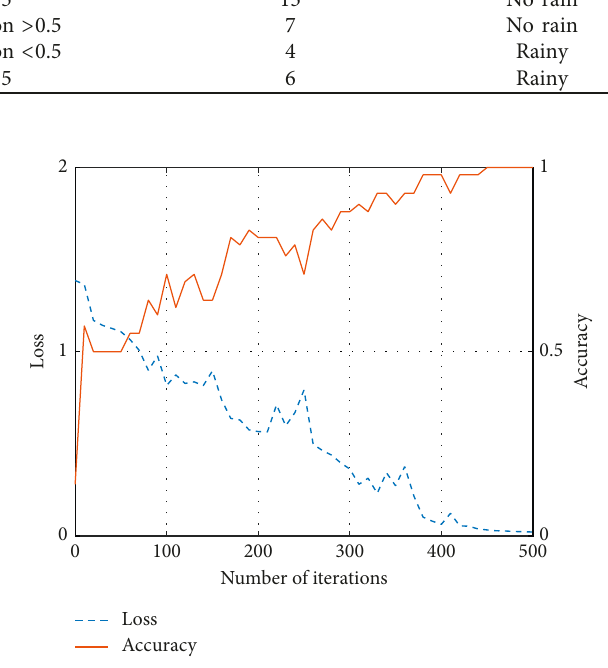
Figure 5: Loss and accuracy curves of rainy-day/rainless-day classifier